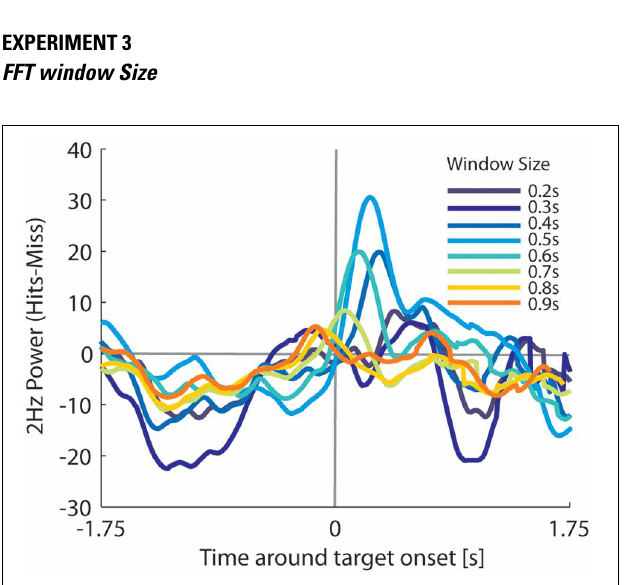
FIGURE A1 | Image set used in Experiment 2. Objects were equal in size, luminance, and global contrast. Four images were randomly selected from this set per trial. Objects were collected from http://www.freeimages.co.uk/.